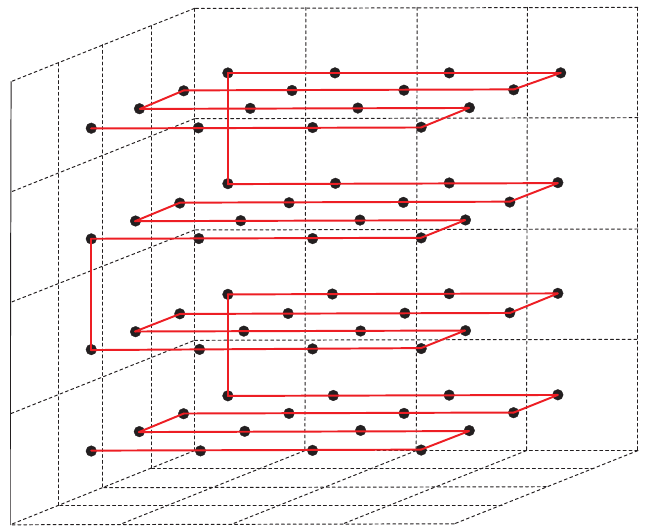
Figure 4. Layered-scan of the